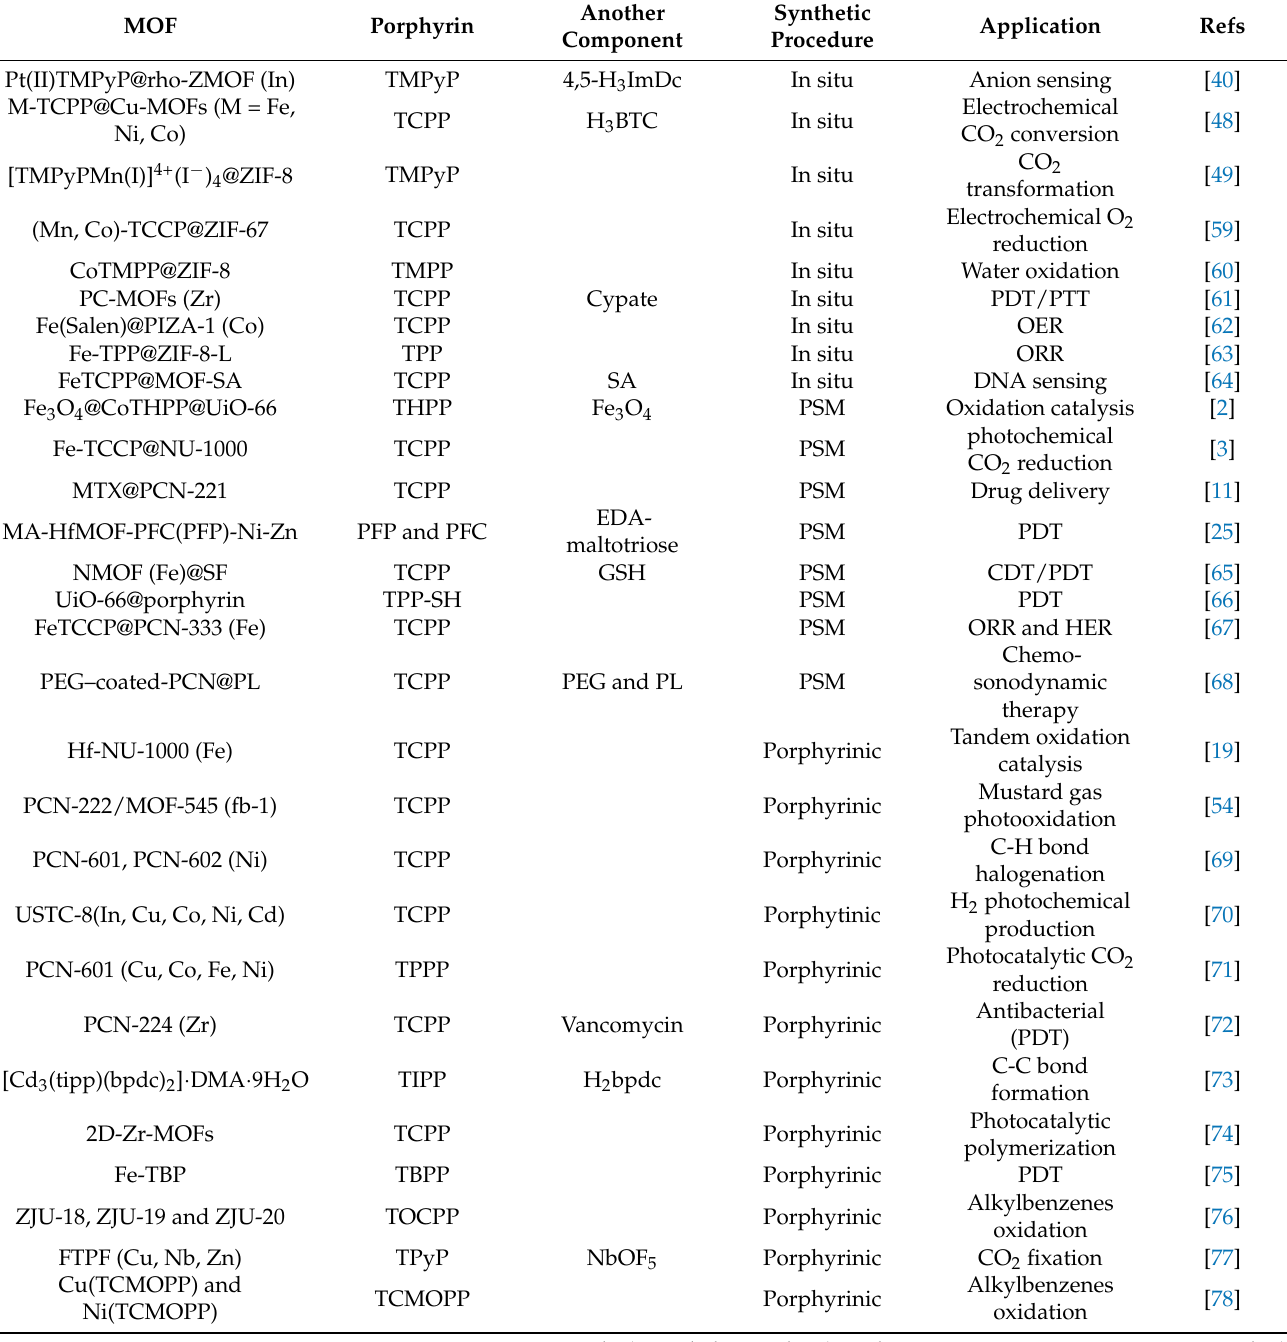
Table 2. Representative list of metalloporphyrin metal–organic frameworks and their